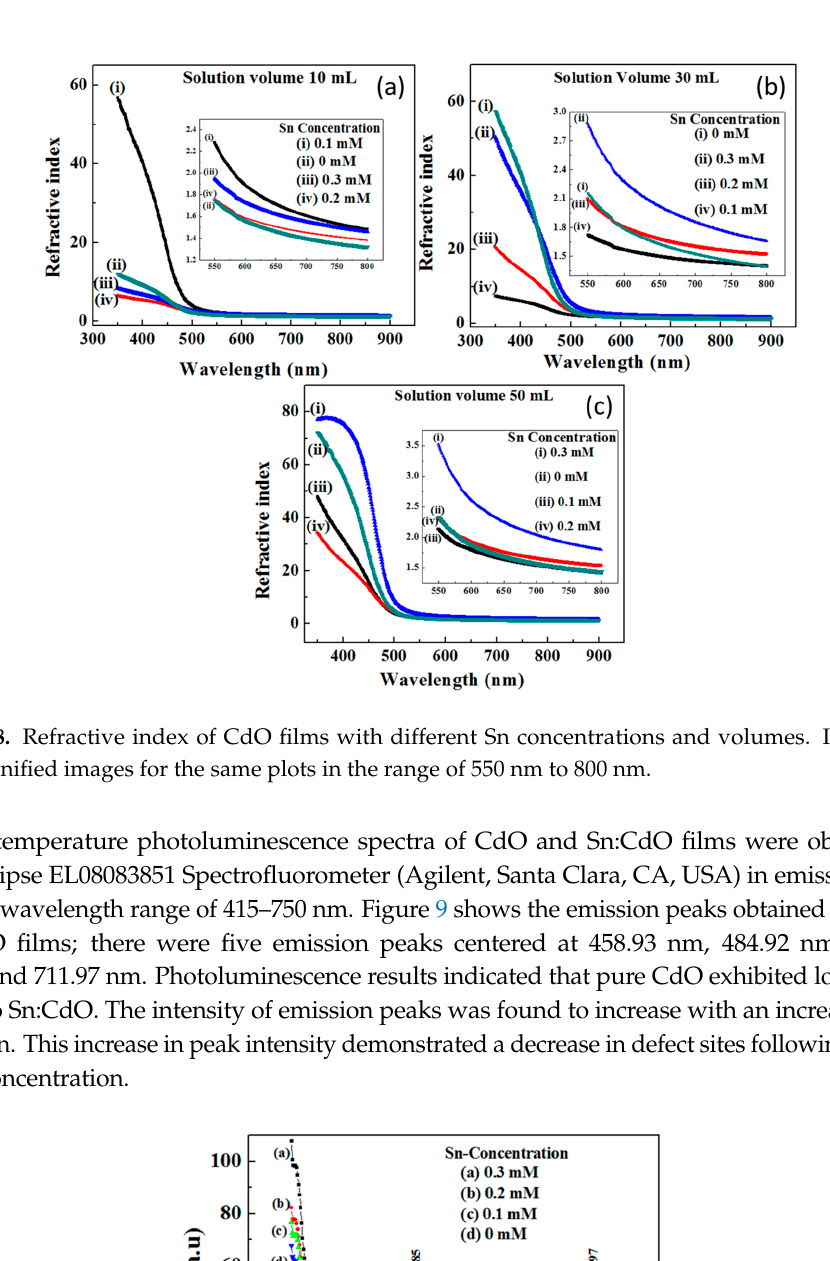
Figure 9. Photoluminescence spectrum of CdO films with different Sn concentrations.